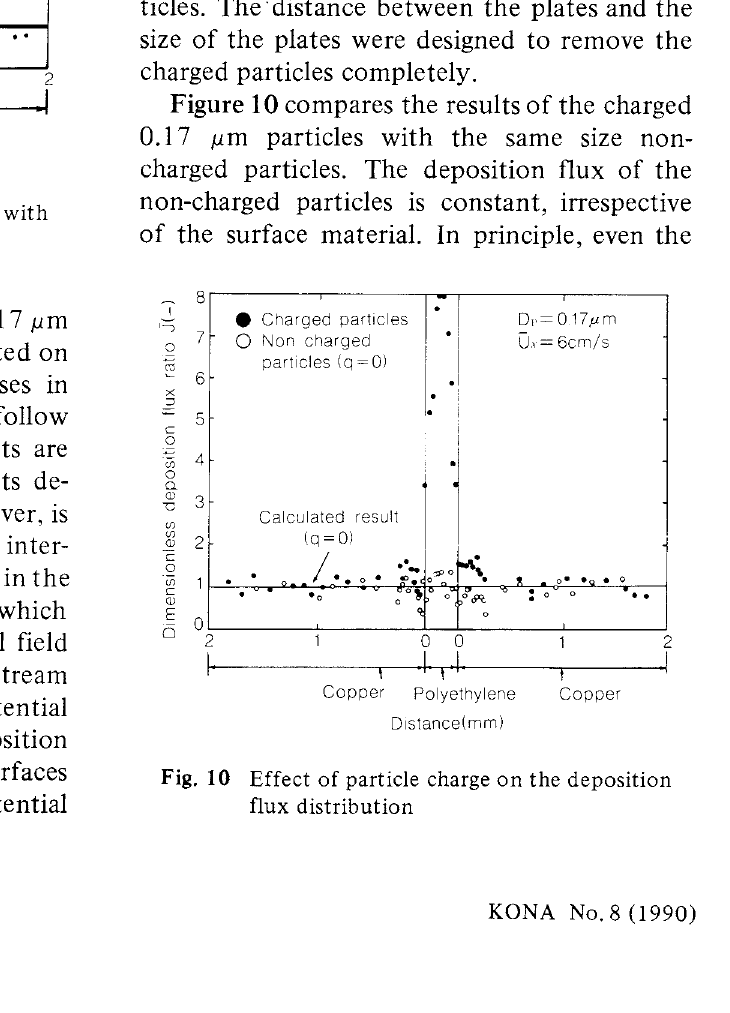
Fig. I 0 Effect of particle charge on the deposition flux